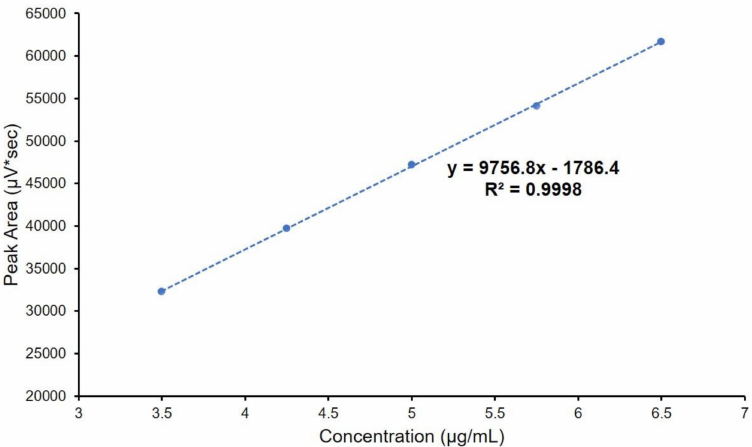
Figure 7. Graph representing hexoprenaline sulphate linearity results, including the linear equation.